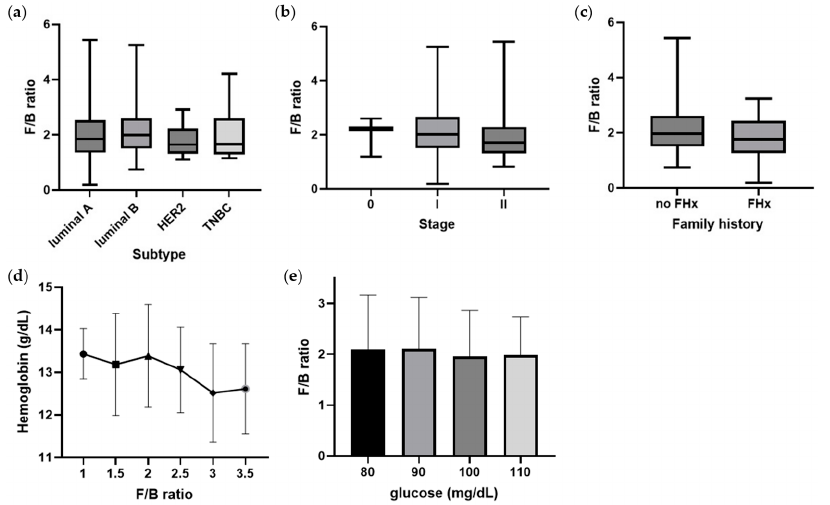
Figure 4. F/B ratio in patients with breast cancer. ( a ) The relationship between F/B ratio and subtypes of breast cancer (luminal A, luminal B, human epidermal growth factor receptor 2 (HER2), or triple negative breast cancer (TNBC)). ( b ) The relationship between F/B ratio and stage of breast cancer. ( c ) The relationship between F/B ratio and family history (FHx). ( d ) The relationship between F/B ratio and hemoglobin level (g/dL). ( e ) The relationship between F/B ratio and fasting serum glucose levels (mg/dL).